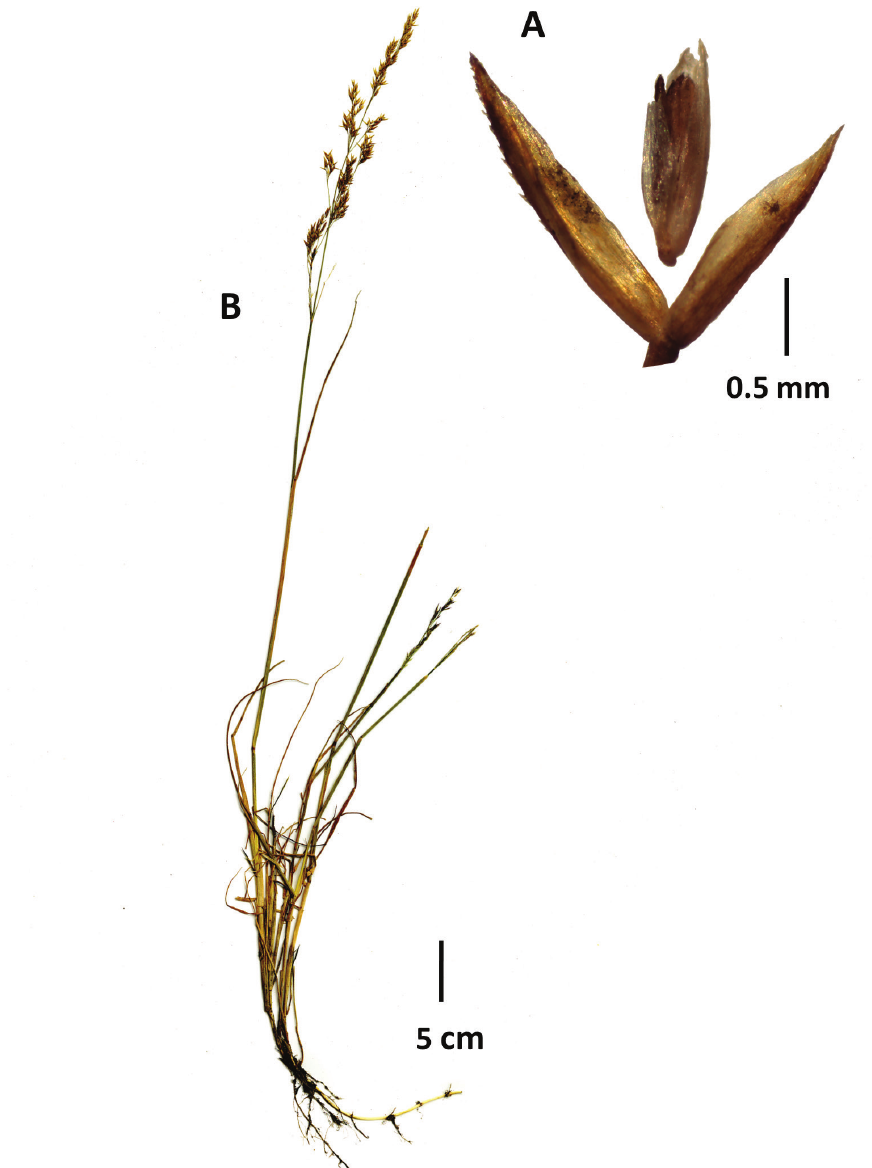
Figure 4. Agrostis capillaris A spikelet, lateral view, with floret detached and raised above the glumes B Whole plant. Images of Sylvester 3021